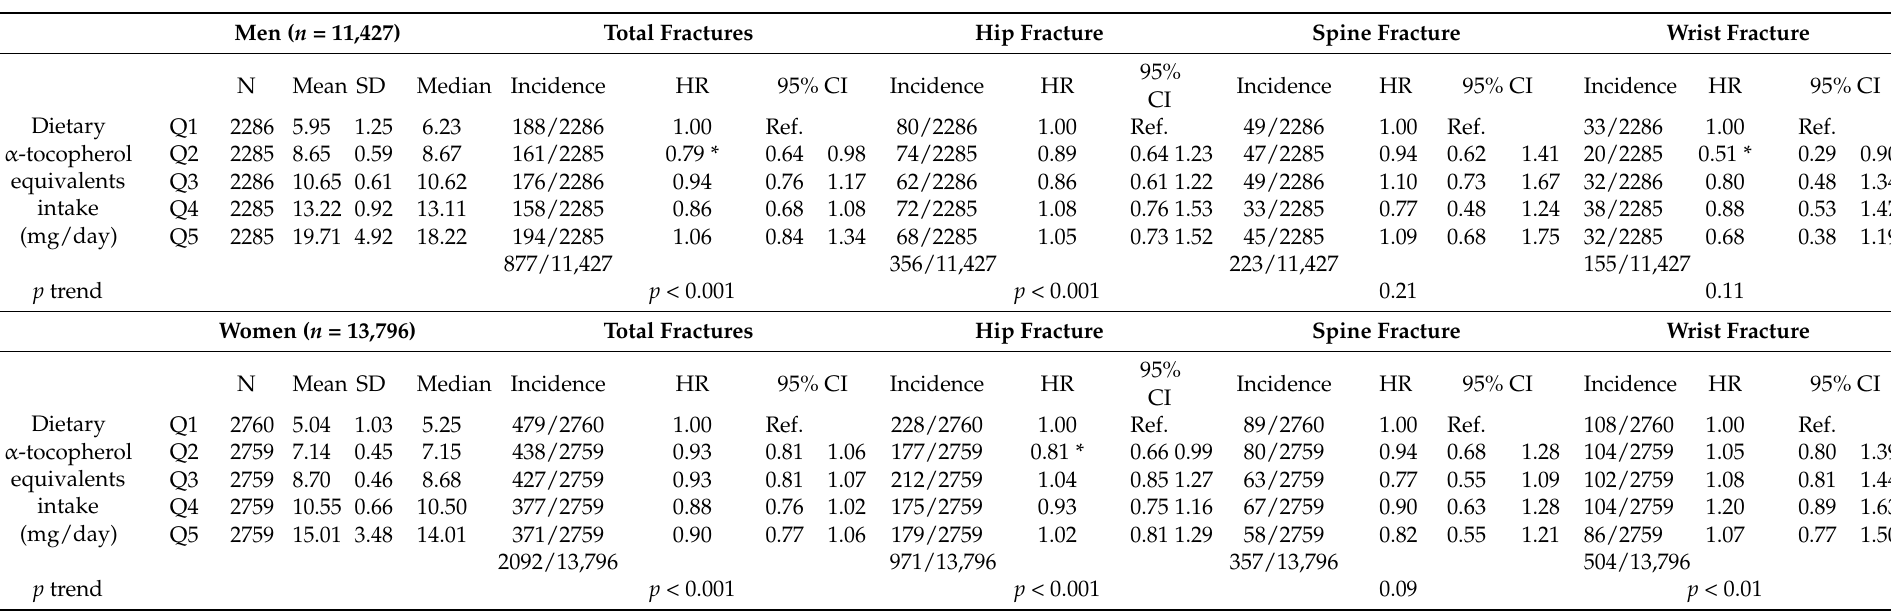
Table 7. Risk of total, hip, spine and wrist fractures in EPIC-Norfolk participants, stratified by sex and quintiles of dietary vitamin E intake ( n =